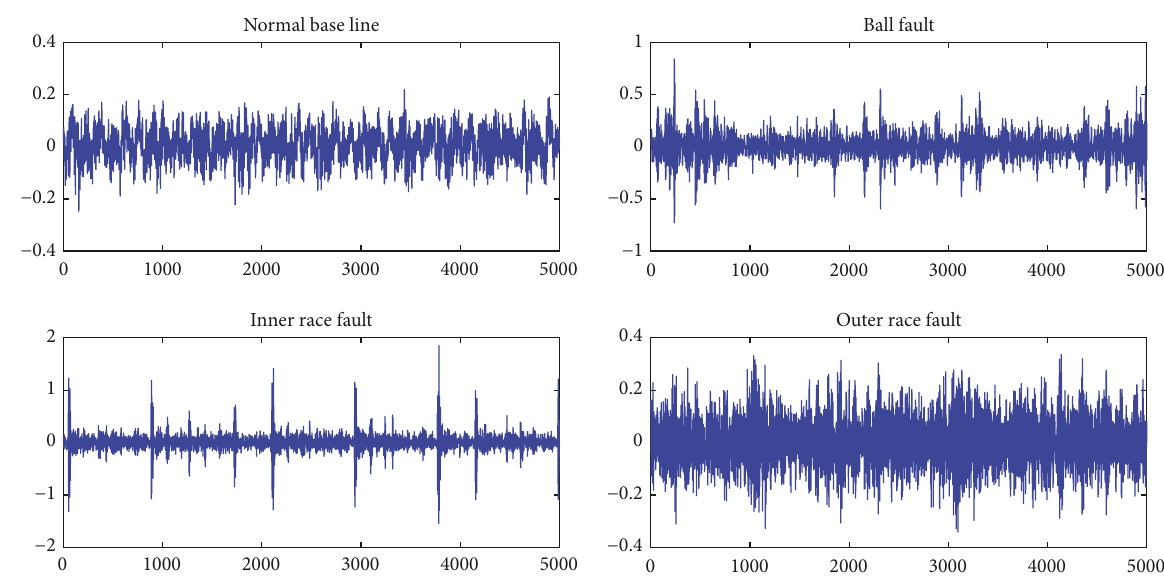
Figure 3: Vibration signals of normal bearing and faults of drive end